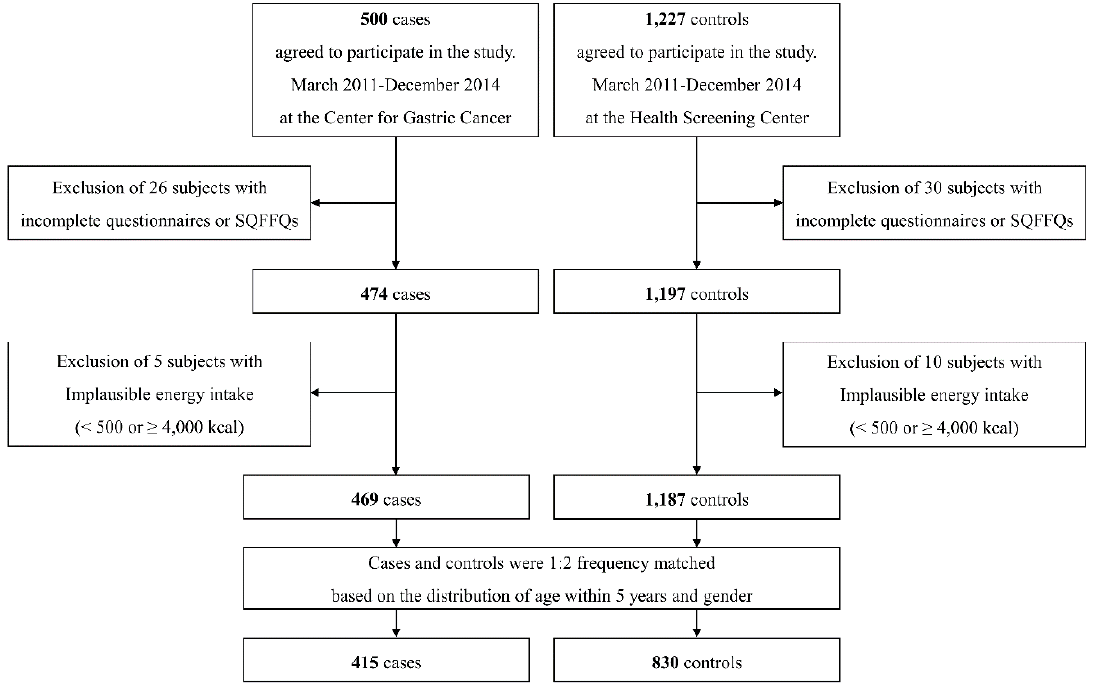
Figure 1. Flow chart of the study subjects. SQFFQ: semi-quantitative food frequency questionnaire.